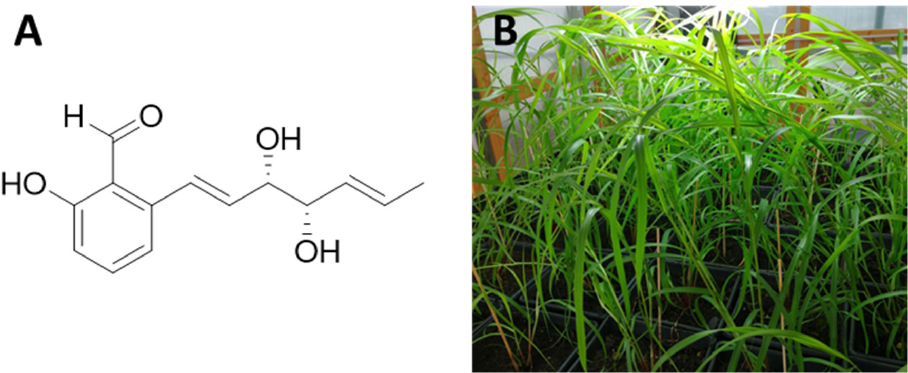
Figure 1. ( A ) Structure of (10 S ,11 S )-(—)- epi -pyriculol (EPYR); ( B ) greenhouse-grown Cenchrus ciliaris (buffelgrass).